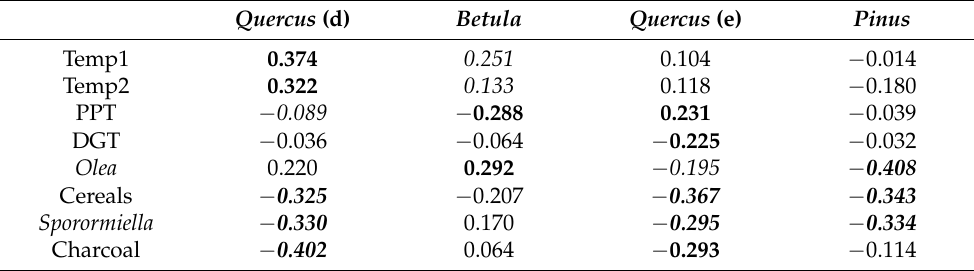
Table 2. Linear (normal font) and exponential (italics) correlation coefficients between the forest taxa and the external drivers that were significant in the Gaussian response analysis (Figures 10 and 11). In most significant cases, the linear and exponential models showed very similar correlation coefficients, and the higher values were chosen. Correlations significant at p < 0.05 are in bold.